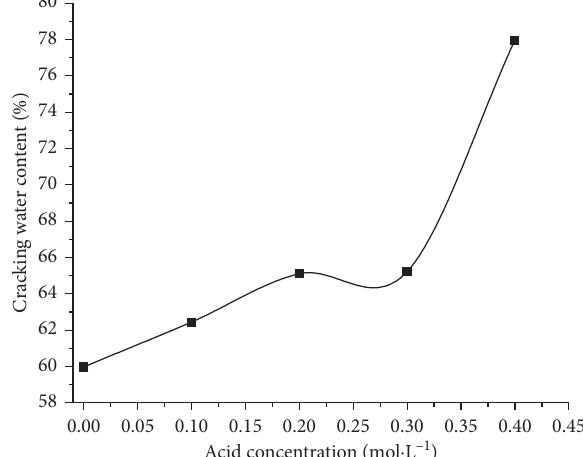
Figure 7: Critical moisture content with crack formation in contaminated samples with different acid